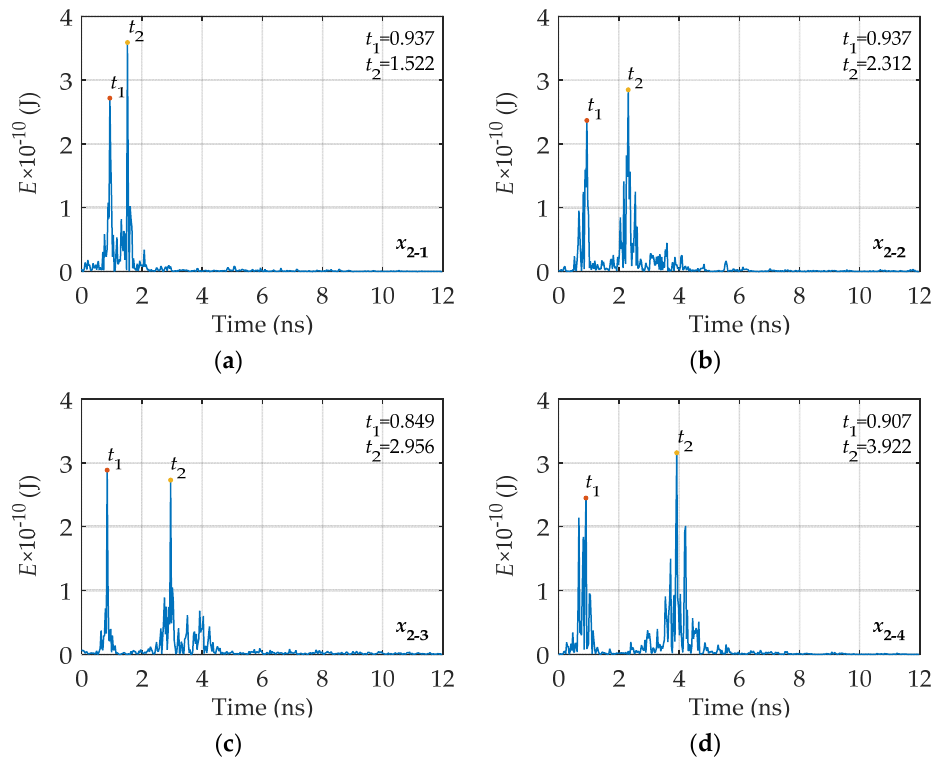
: ( a ) x 2 2 1 − : ( a ) x represents the signal of the 10 cm model box; 2 2 1 − 2 2 − represents the signal of the 10 cm model box; represents the signal of the 20 cm 2 2 − 2 4 − represents the signal of the 20 cm 2 4 −